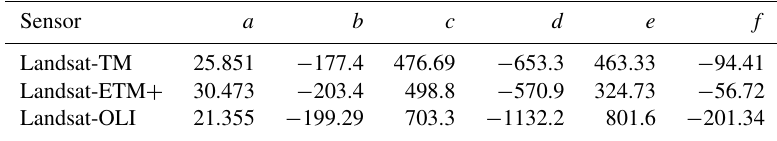
Table 1. Polynomial coefficients for the Landsat-OLI/TM/ETM + hue angle correction (Wang, 2018). Sensor a b